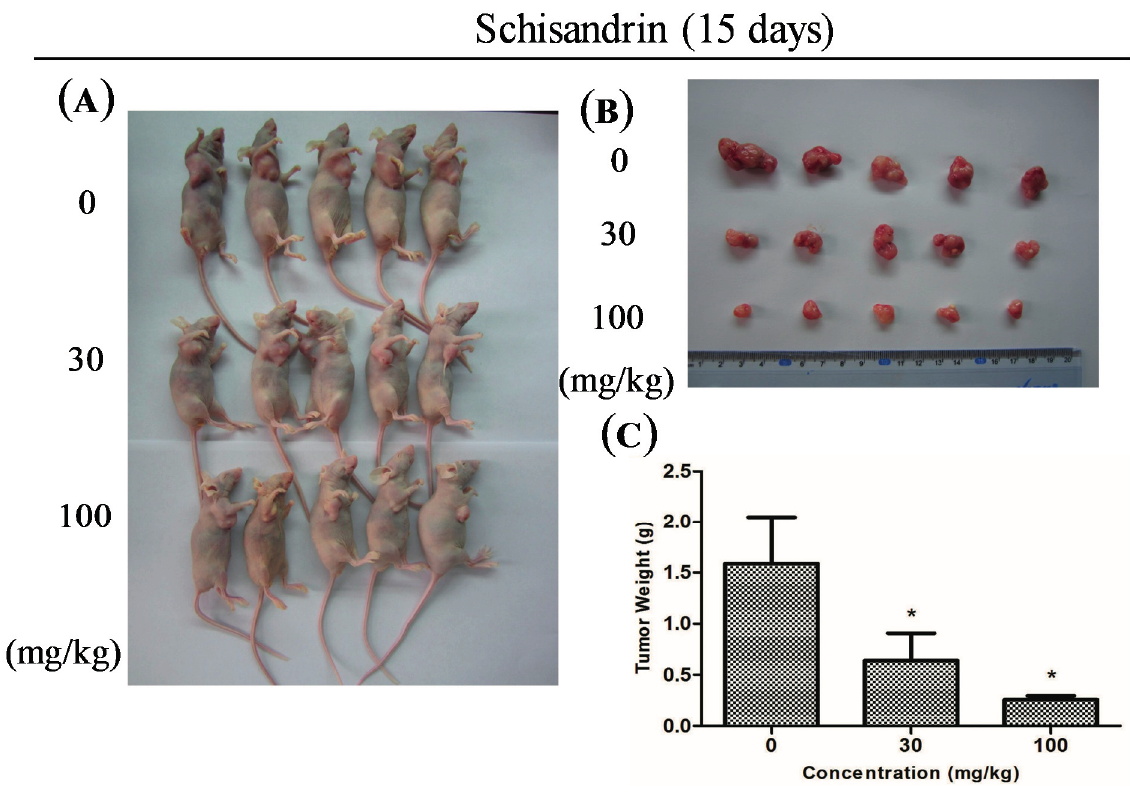
Figure 7. Sch B potentiates the in vivo antitumor effect. ( A) NOZ cells were subcutaneously injected into the right flank of the nude mice; The mice were then administered 0.2 mL of vehicle (10% DMSO and 90% PBS) or Sch B (30 mg/kg and 100 mg/kg) intraperitoneally every 2 days for up to 15 days. Photos of 5 representative mice (n = 10) from each group were presented to show the sizes of the resulting tumors; ( B , C ) Tumors were excised from the animals and weighed. * P < 0.05 vs. the control